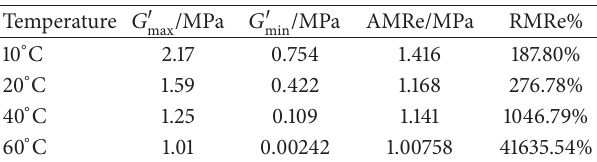
Table 5: 𝐺 󸀠 max , 𝐺 󸀠 min , AMRe, and RMRe% of MRSP-4 with externally applied magnetic field at different temperatures.